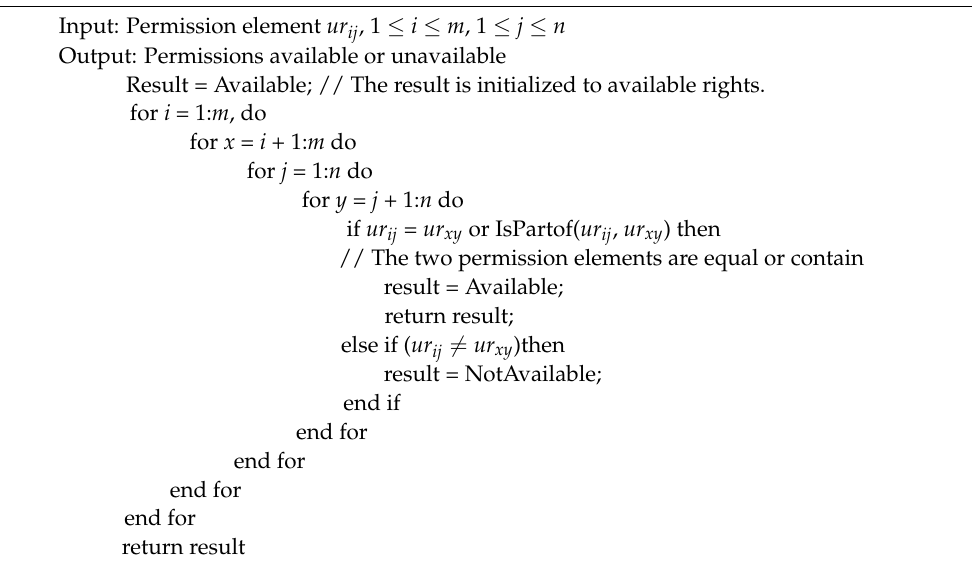
Algorithm 1. The algorithm of permission availability detection.